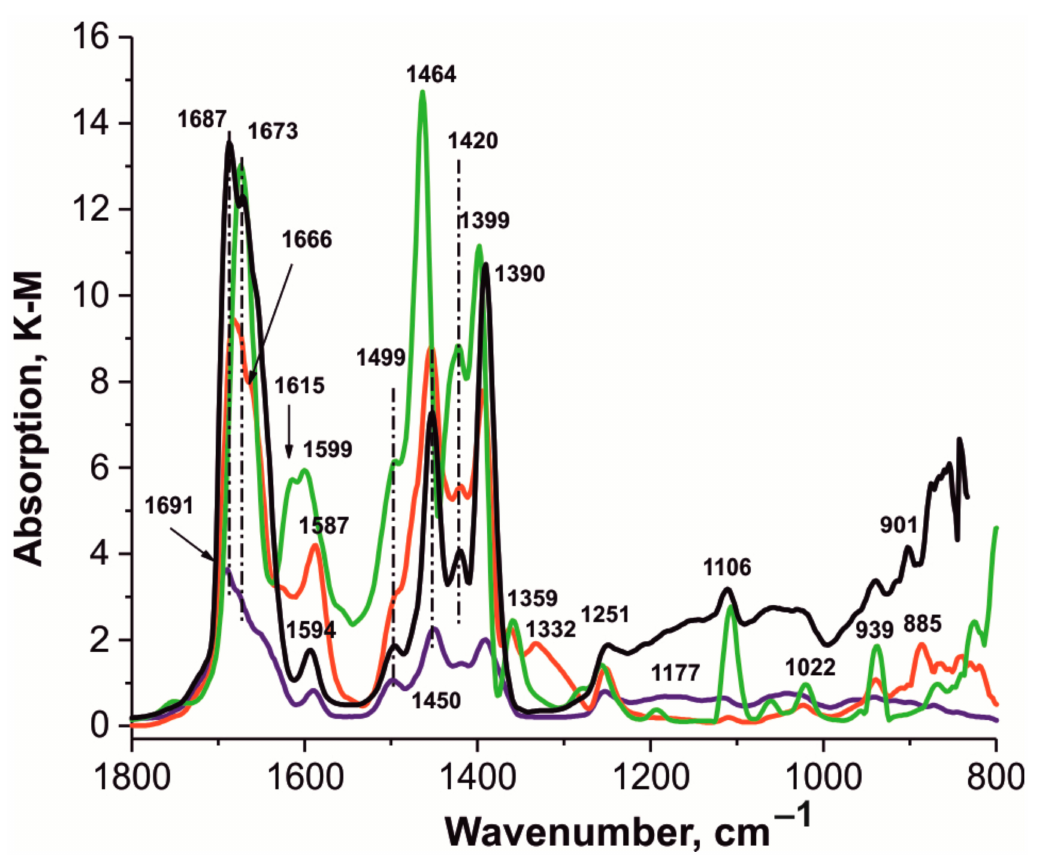
Figure 8. DRIFT spectra of the 1 (black), 2 (red), and 3 (blue) HKUST-1@BPS composites and the HKUST-1 mw reference sample (green) in the frequency range of 1800–750 cm − 1